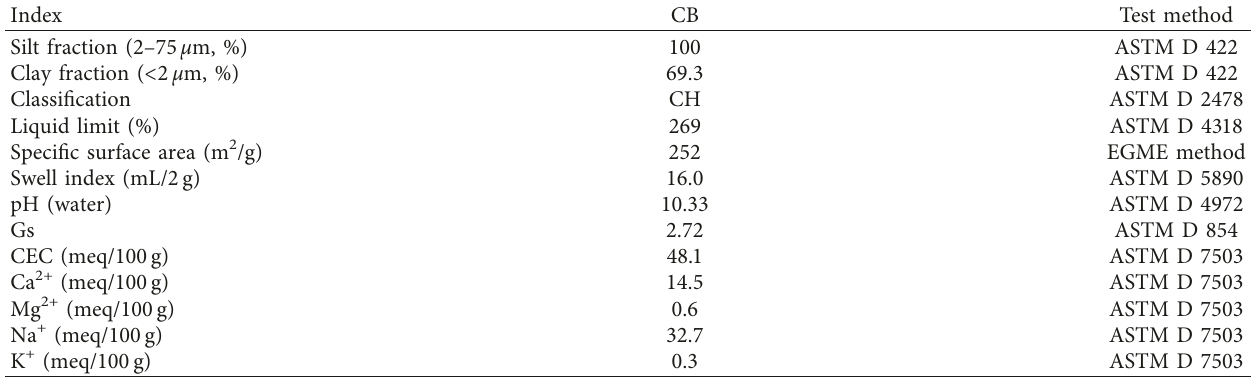
Table 1: Properties of CB used in this study.